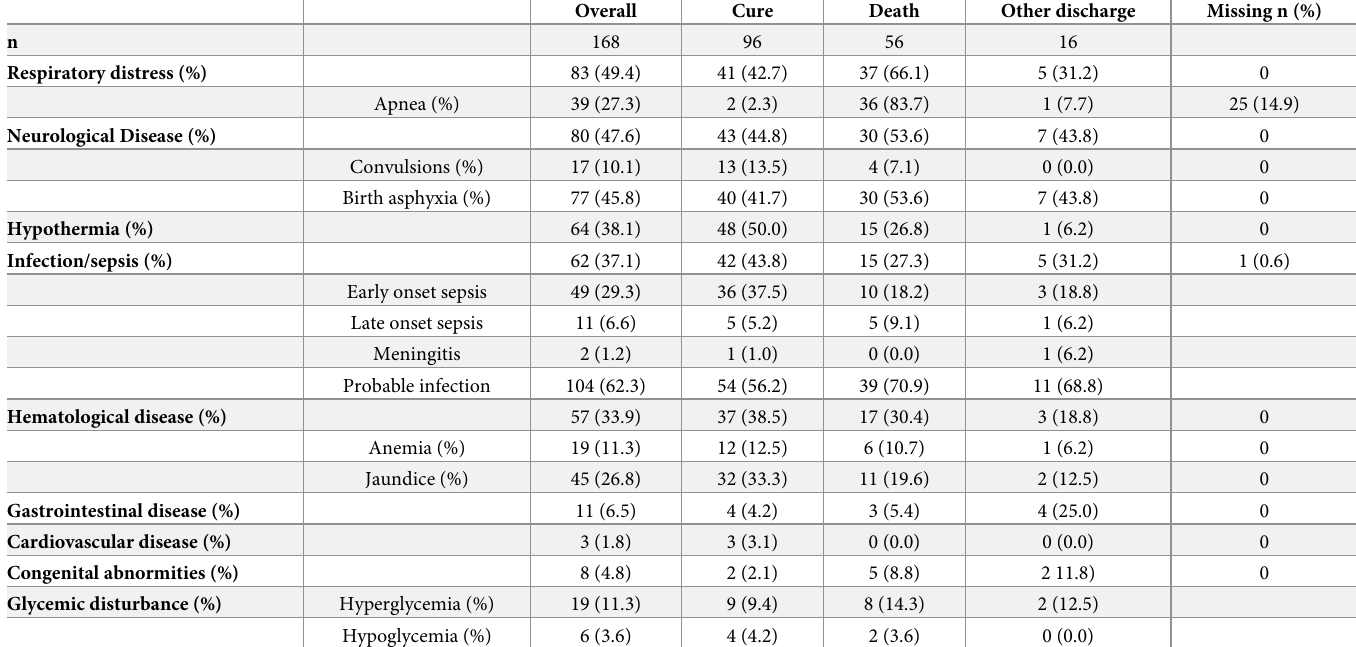
Table 6. The most common patient pathologies of newborns admitted to INSE, stratified by neonatal outcomes (cure or death during hospital stay or other discharge).